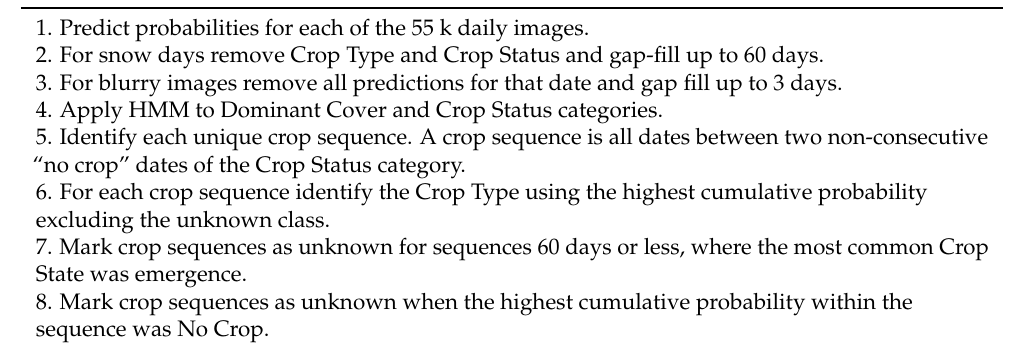
Table 2. The post-processing steps performed on the VGG16 model